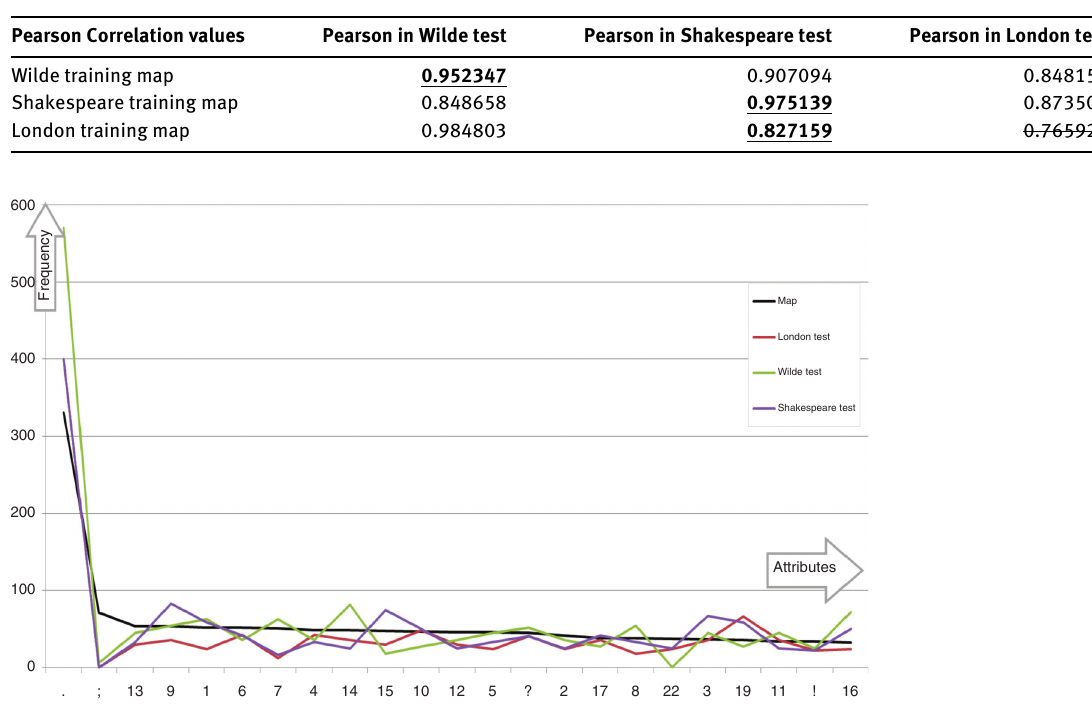
Figure 2: Shakespeare’s Map vs. Authors’ Test